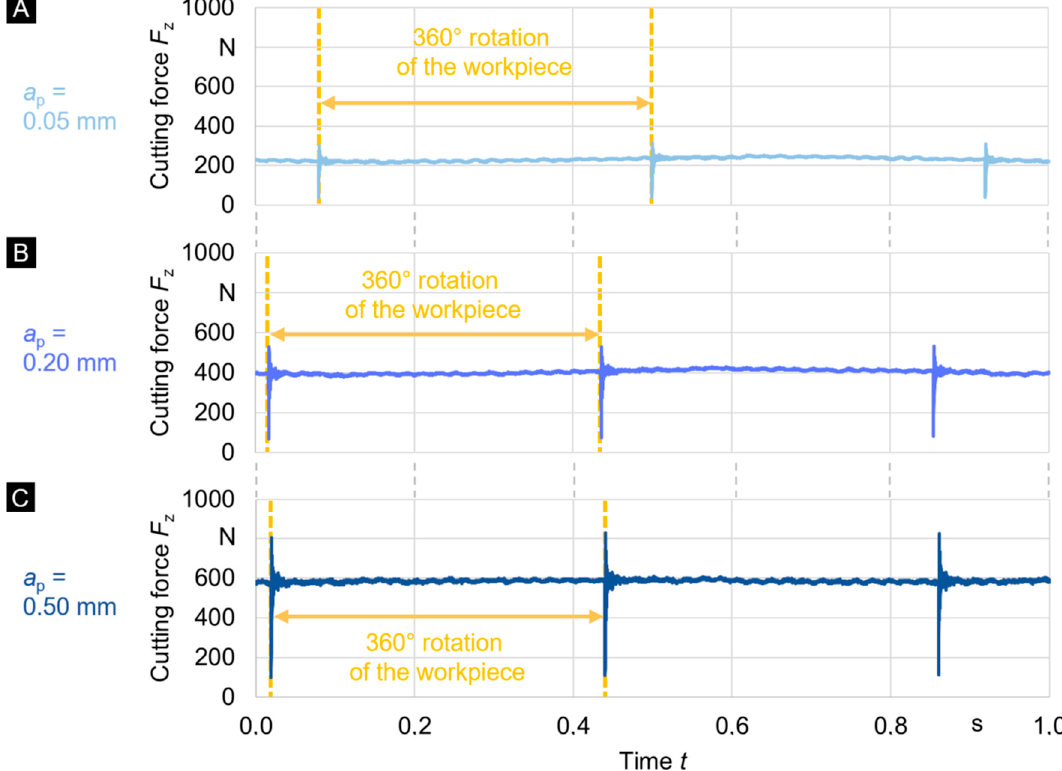
Figure 8. Signals of the process force component at a depth of cut ap of 0.05 mm ( A ), 0.2 mm ( B ) and 0.5 mm ( C ).